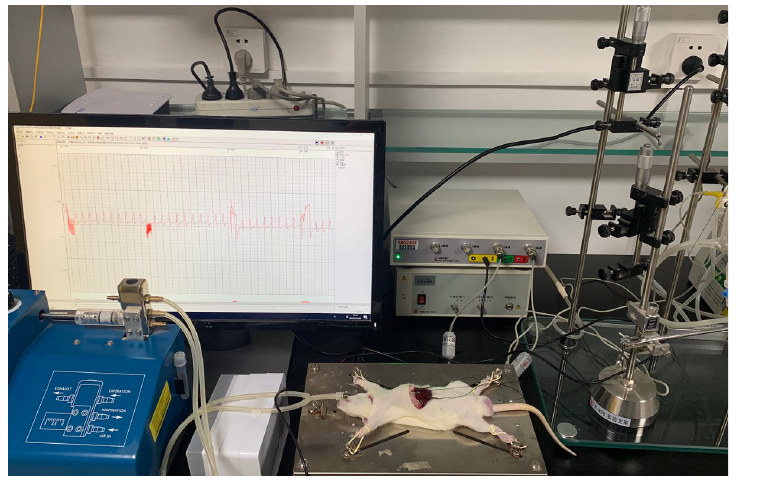
Fig 1. Equipment for in vivo diaphragmatic tonus